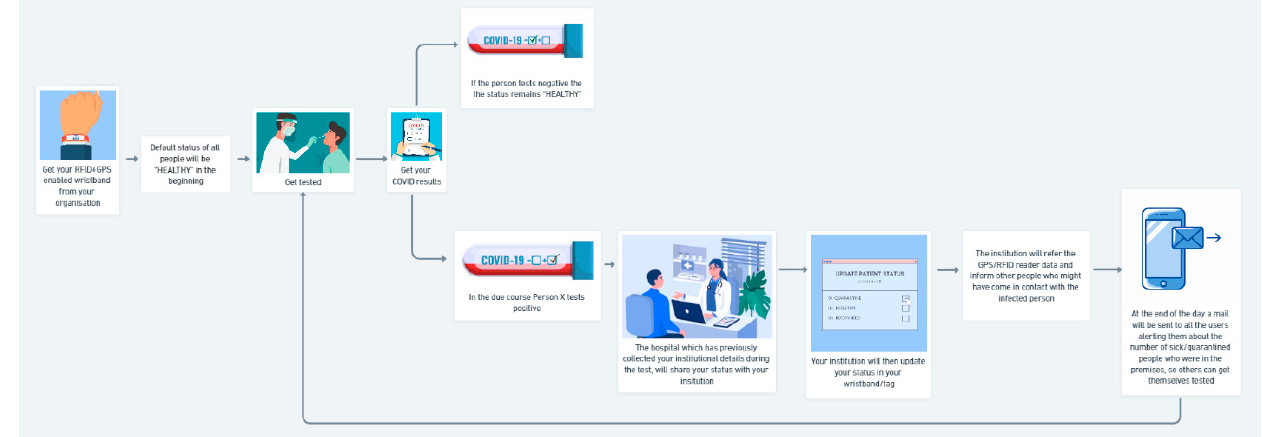
Figure 4. Overall block diagram of automatic people tracking and contact tracing system.